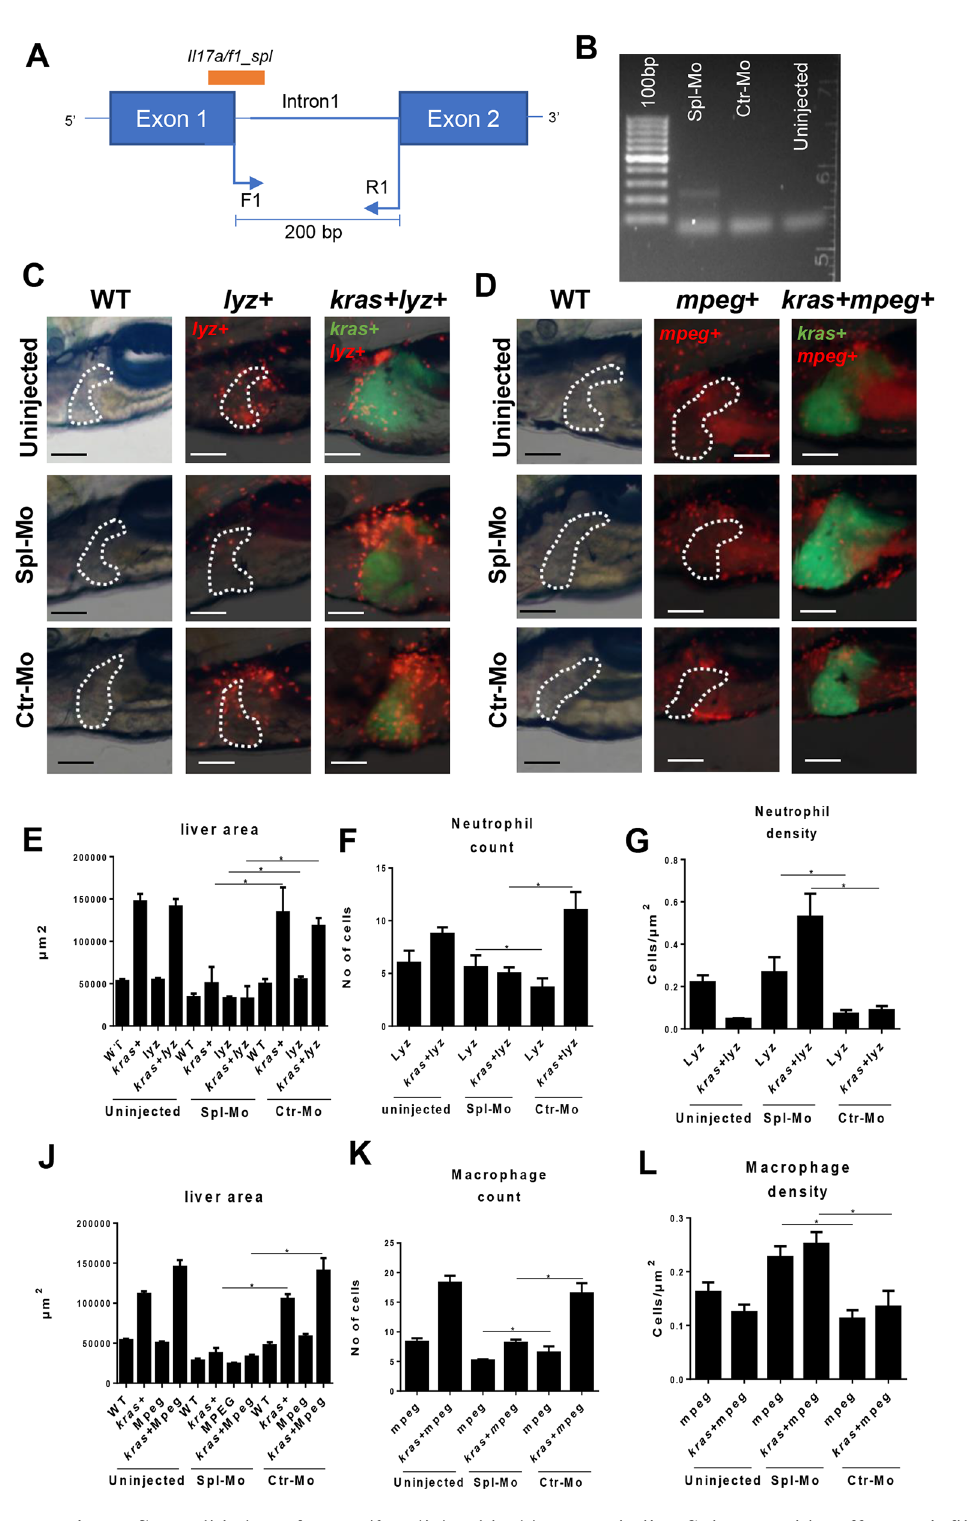
Figure 6. Validation of iL17a/f1 splicing blocking morpholino Spl-Mo and its effect on infiltration of neutrophils and macrophages in the liver. ( A ) Diagram of iL17a/f1 gene for the targeted sites of Spl-Mo and PCR primers. A 200-bp fragment is expected when Spl-Mo blocks the splicing. ( B ) Agarose gel electrophoresis of RT-PCR products after introduction of Spl-Mo. Mopholinos were introduced into zebrafish embryos at one cell stage and RNA was isolated at 6 hpf for RT-PCR analysis. ( C , D ) Representative images of liver-infiltrated neutrophils ( C ) and macrophages ( D ) after il17a/f1 knockdown by Spl-Mo. Lyz + and mpeg + transgenic zebrafish were used for marking neutrophils (dsRed expression) and macrophages (mCherry expression) respectively and these transgenic fish were compounded with kras + zebrafish for investigation of liver-infiltrated immune cells. Livers are outlined for non- kras + samples. ( E – G ) Quantification of liver size ( E ), number ( F ) and density ( G ) of liver-infiltrated neutrophils. ( J – L ) Quantification of liver size ( J ), number ( K ) and density ( L ) of liver-infiltrated macrophages. N = 10 per group. Scale bars: 100 μm. Statistical significance: *P ˂